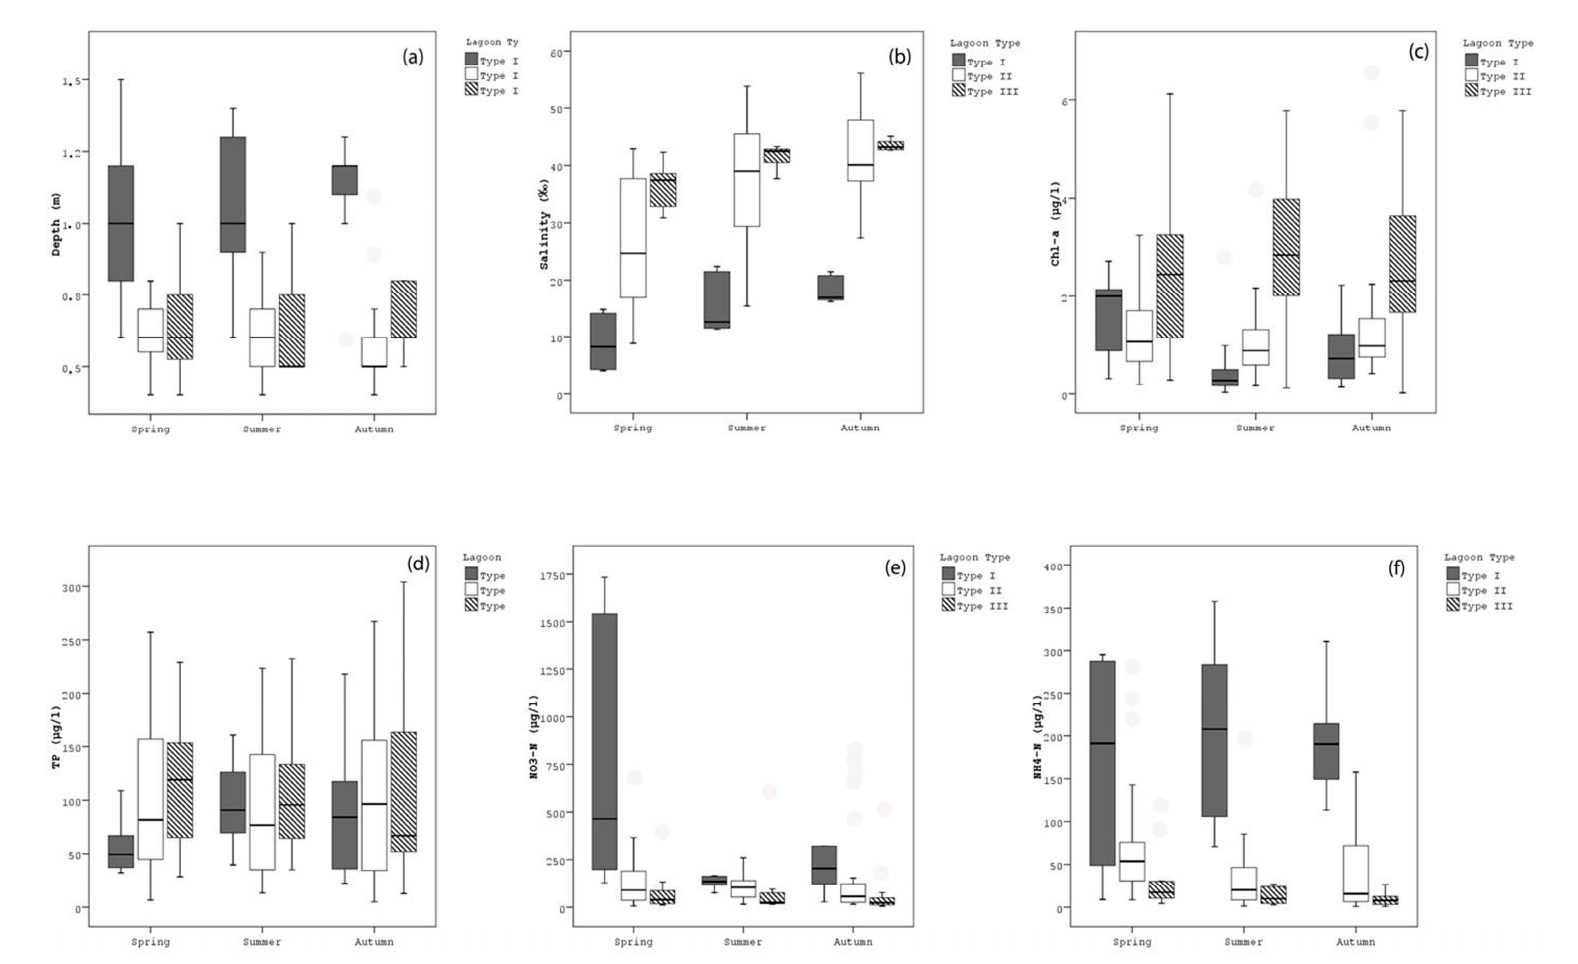
Figure 2. Seasonal variability of: ( a ) water depth (m); ( b ) salinity ( ‰ ); ( c ) Chl- a ( µ g/L); ( d ) TP ( µ g/L); ( e ) NO 3 -N ( µ g/L); ( f ) NH 4 -N ( µ g/L) concentrations in the three lagoon types of Western Greece during the whole sampling period.